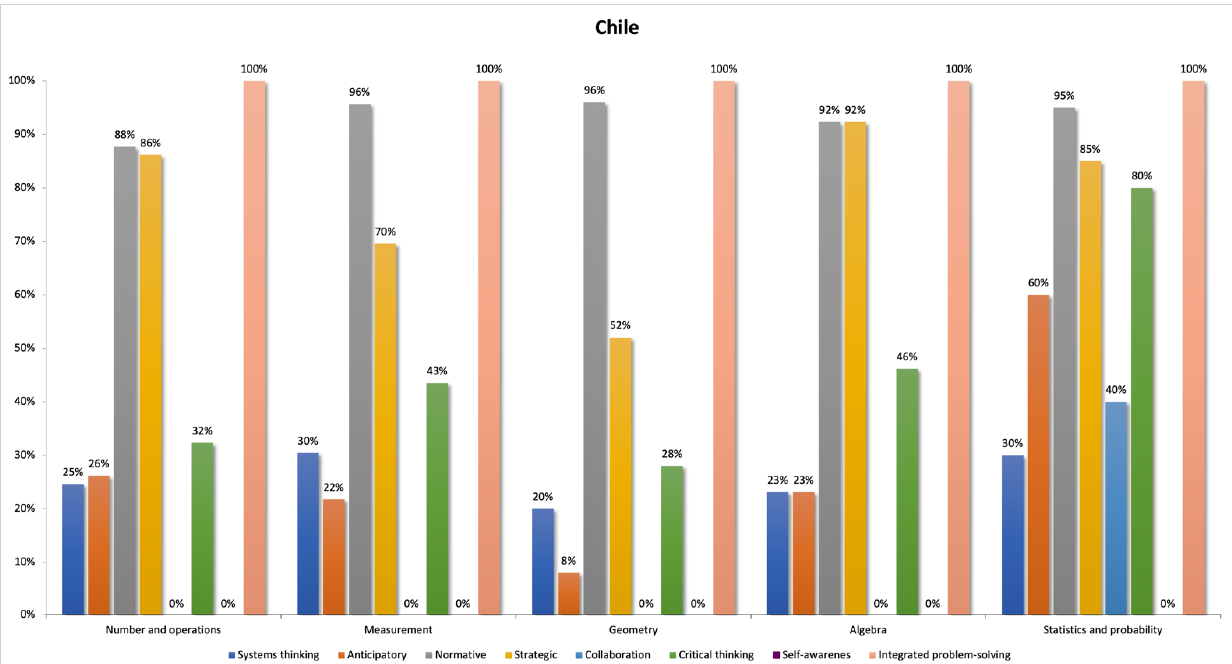
Figure 3. Sustainability competence distribution in Chile according to thematic axis.